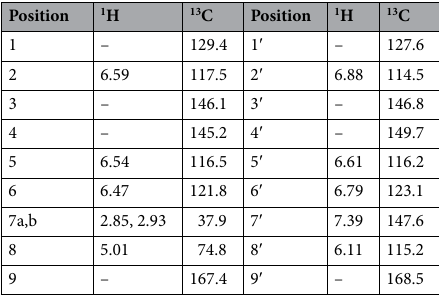
Table 1. 1 H NMR and 13 C NMR chemical shifts of